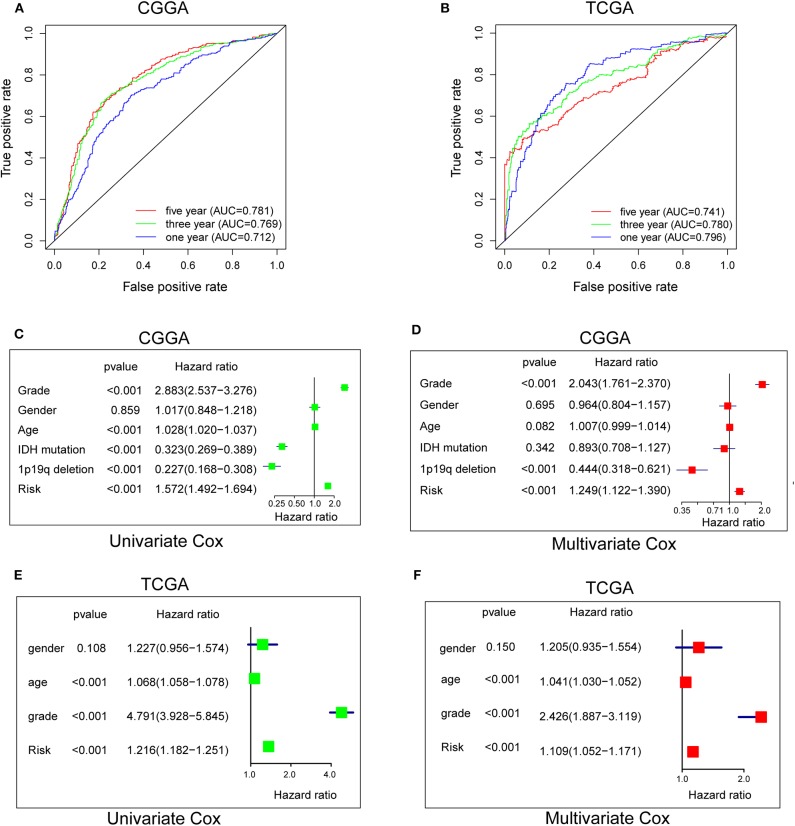
Prognostic value of the hypoxia risk signature in glioma. (A,B) ROC curves showing the predictive efficiency of the hypoxia risk signature on the 1-, 3-, and 5-years survival rate; (C–F) Univariate and multivariate Cox analyses evaluating the independent prognostic value of the hypoxia signature in terms of OS in glioma patients.